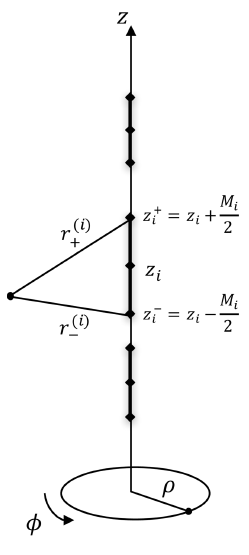
Figure 1 . Schematic description of axisymmetric rod